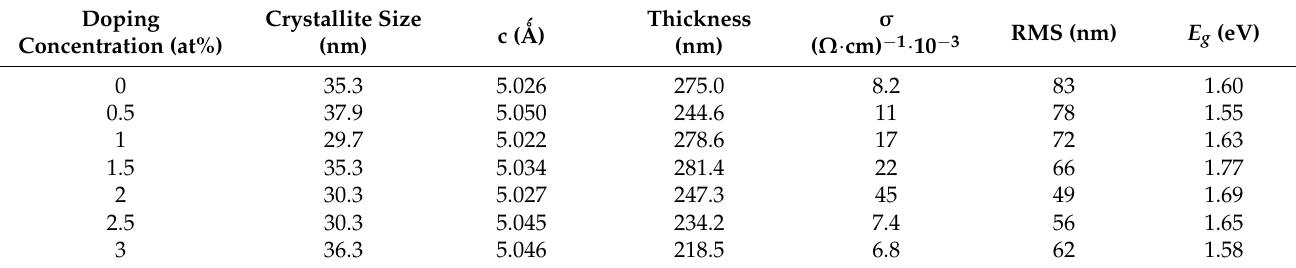
Table 1. The crystallite size ( D ), the lattice parameter c, the conductivity (σ), the thickness ( e ), the root mean square (RMS), and the band gap ( Eg ) of CuO thin films with 5 layers at various doping concentrations.